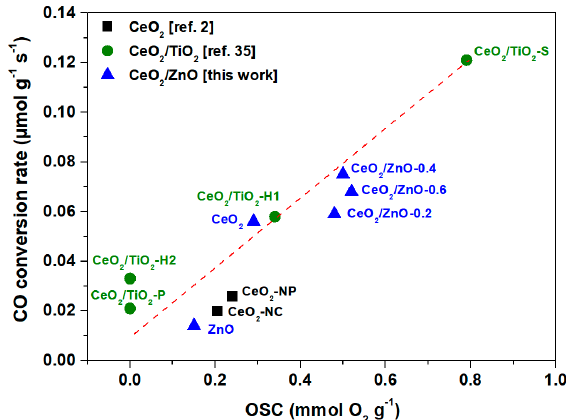
Figure 7. Correlation of specific activity with oxygen storage capacity (OSC). Literature data are also included. Specific rates were obtained at 200 °C under the reaction conditions: 0.2 vol.% CO and 1 vol.% O 2 in He. The dotted line simply represents the general trend of the data. The designation of the samples inside the figure refers to CeO 2 nanopolyhedra (CeO 2 –NP), CeO 2 nanocubes (CeO 2 –NC),